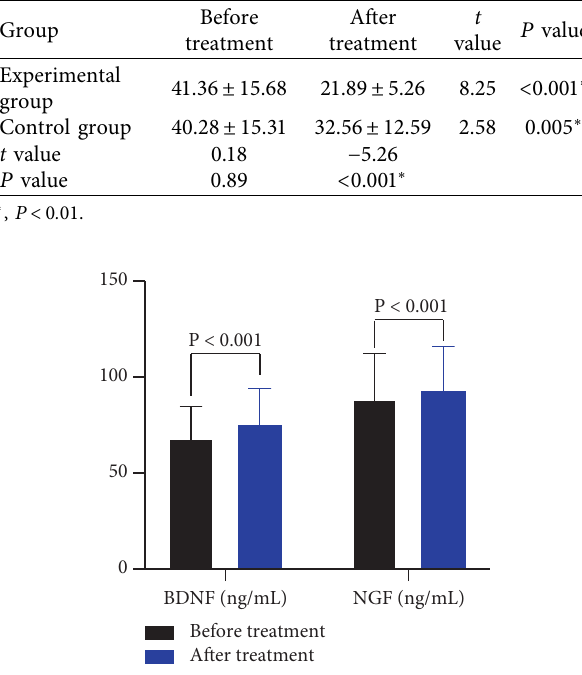
Figure 1: The serum levels of BDNF and NGF in patients with depression before and after